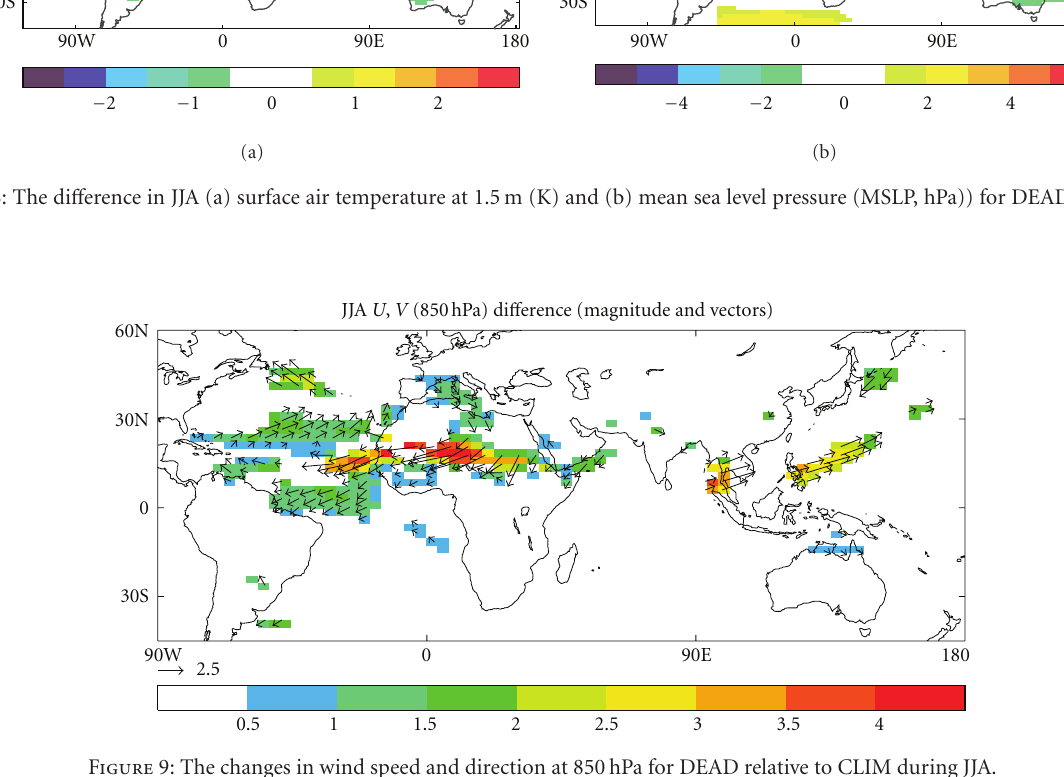
Figure 9: The changes in wind speed and direction at 850 hPa for DEAD relative to CLIM during JJA.